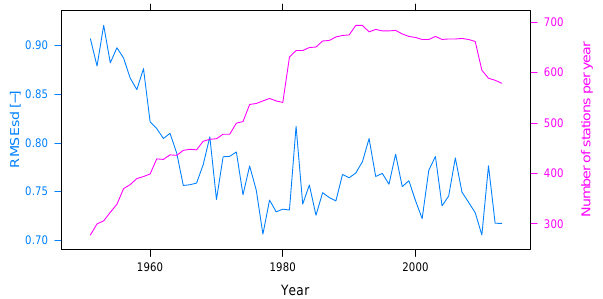
Figure 7. Annual RMSEsd median (blue) and number of available stations per year (pink) for precipitation in the period 1951–2013. The daily results, also summarized in Table 1, were used for calcu- lating the annual medians.